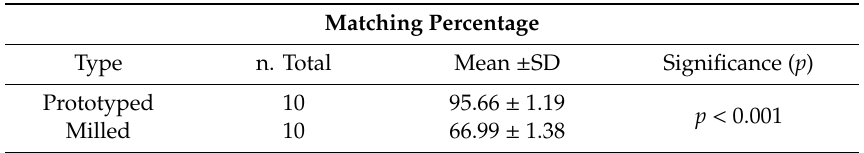
Table 2. Comparative data of percentage of matching between milled and prototyped splints related to the 3D project. p value based on Student’s t test and set at p <